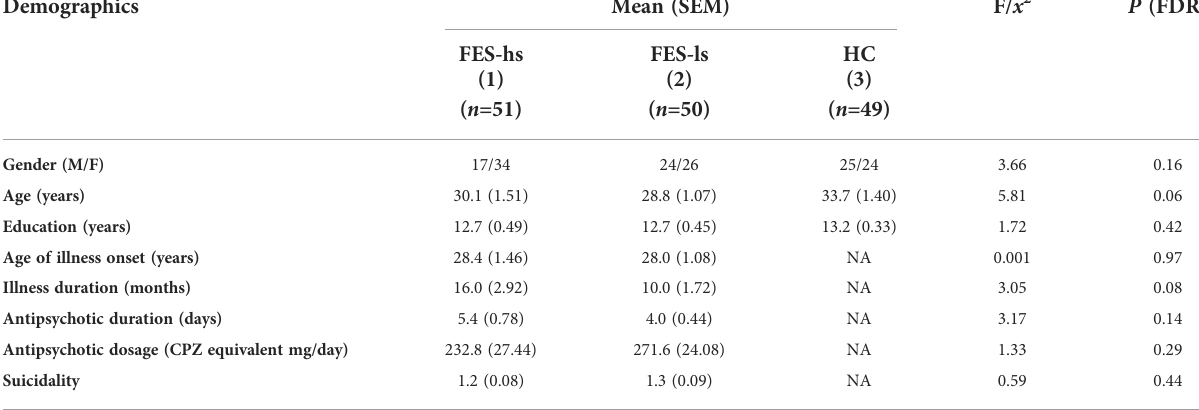
TABLE 1 Demographic characteristics of FES patients and HCs.